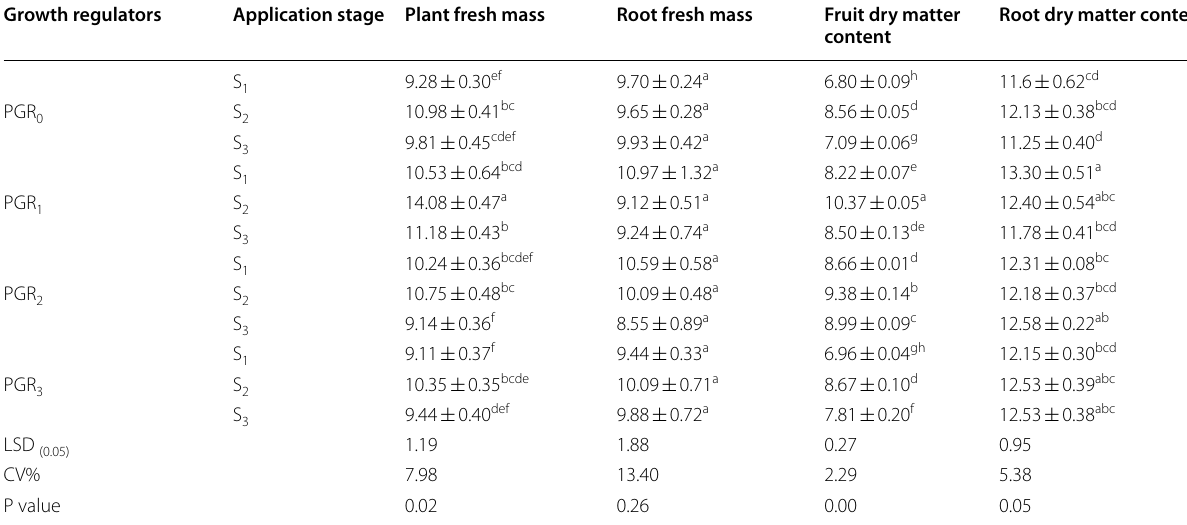
Table 3 Influenced of different plant growth regulators on the fresh mass of plant (kg), fresh root mass (g), fruit dry matter content (%) and root dry matter content (%) at various stages of bitter gourd Growth regulators